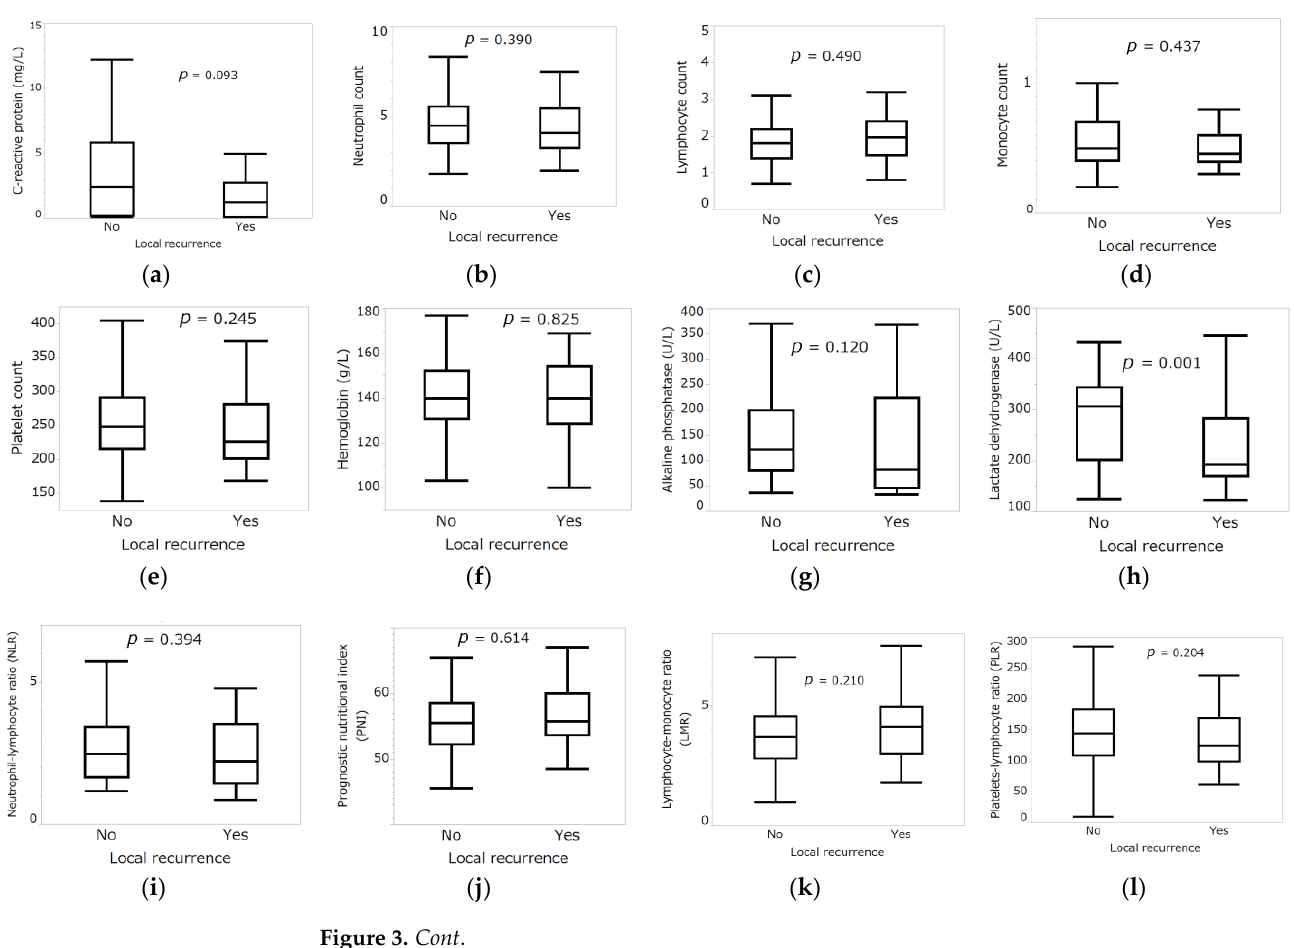
( m ) Figure 3. ( a ) Mann-Whitney U test comparing C-reactive protein with and without local recurrence. ( b ) Mann-Whitney U test comparing neutrophil count (×10 9 /L) with and without local recurrence. ( c ) Mann-Whitney U test comparing lymphocyte count (×10 9 /L) with and without local recurrence. ( d ) Mann-Whitney U test comparing monocyte count (×10 9 /L) with and without local recurrence. ( e ) Mann-Whitney U test comparing platelet count (×10 9 /L) with and without local recurrence. ( f ) Mann-Whitney U test comparing hemoglobin with and without local recurrence. ( g ) Mann-Whitney U test comparing alkaline phosphatase with and without local recurrence. ( h ) Mann-Whitney U test comparing lactate dehydrogenase with and without local recurrence. ( i ) Mann-Whitney U test com- paring neutrophil-lymphocyte ratio (NLR) with and without local recurrence. ( j ) Mann-Whitney U test comparing prognostic nutritional index (PNI) with and without local recurrence. ( k ) Mann- Whitney U test comparing lymphocyte-monocyte ratio (LMR) with and without local recurrence. ( l ) Mann-Whitney U test comparing platelet – lymphocyte ratio (PLR) with and without local recur- rence. ( m ) Local recurrence-free survival rates of patients by modified Glasgow prognostic score (mGPS). Shading around the curves represents the 95% confidence intervals (CIs). 4. Discussion Several cytokines, such as interleukins (ILs), vascular endothelial growth factor, and tumor necrosis alpha, stimulate the production of granulocytes and platelets during tu- mor growth [35]. In addition, serum albumin and lymphocytes have also been found to exert anti-tumor effects by enhancing the immune response against tumors [36,37]. Thus,